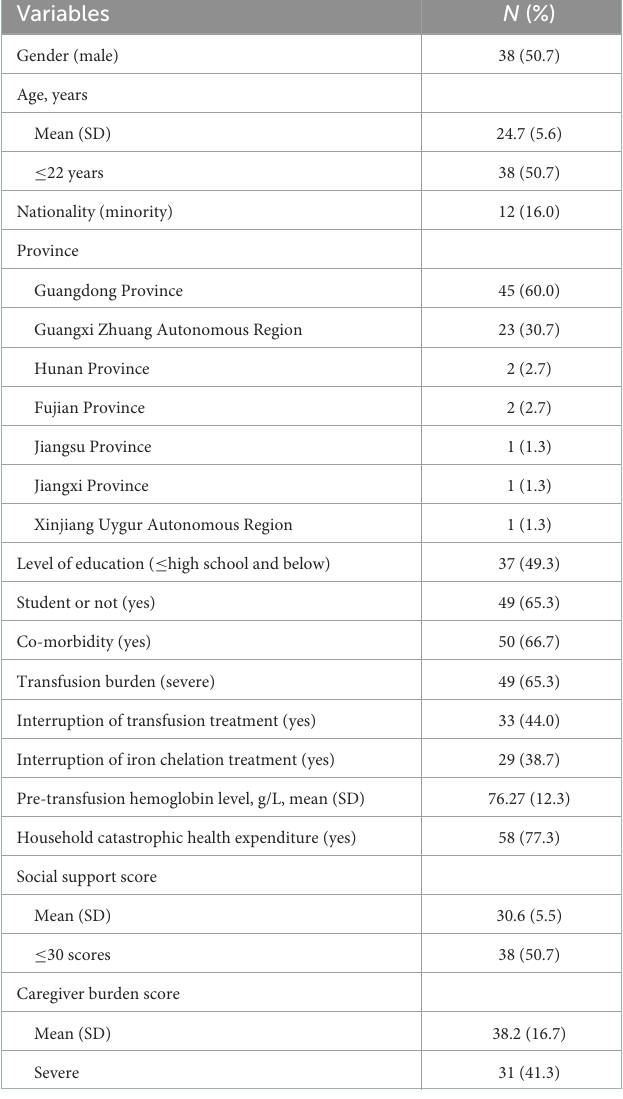
TABLE 1 Characteristics of adult patients with β -thalassemia major ( n = 75).